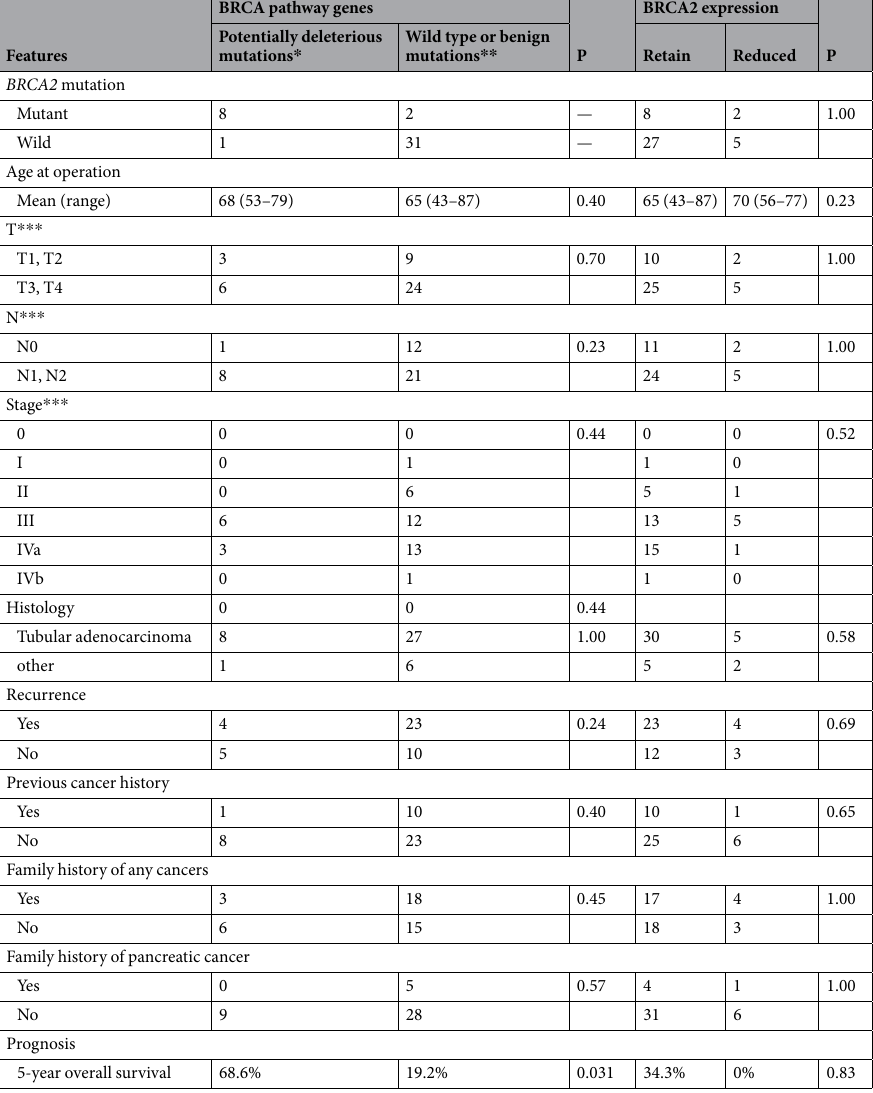
Table 3. BRCA pathway aberrations and clinicopathological features. * Patients with mutations predicted as pathogenic, conflicting, uncertain, or no information by ClinVar. ** Patients with mutations predicted as benign by Clinvar or those without mutations. *** According to Japan Pancreas Society Classification (6 th